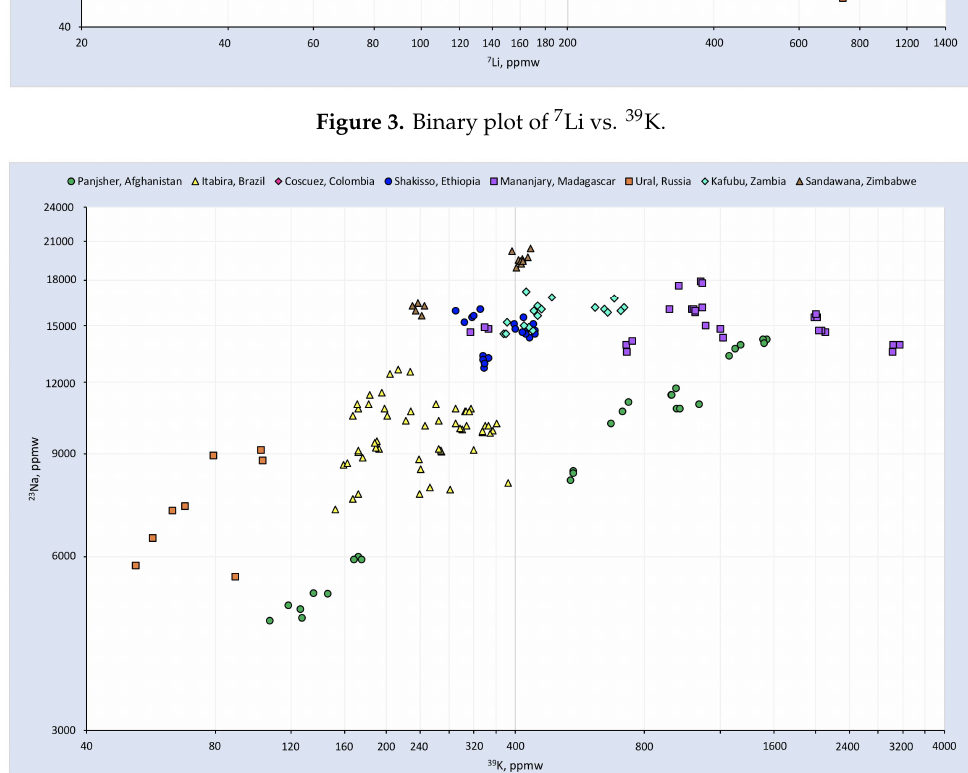
Figure 4. Binary plot of 39 K vs. 23